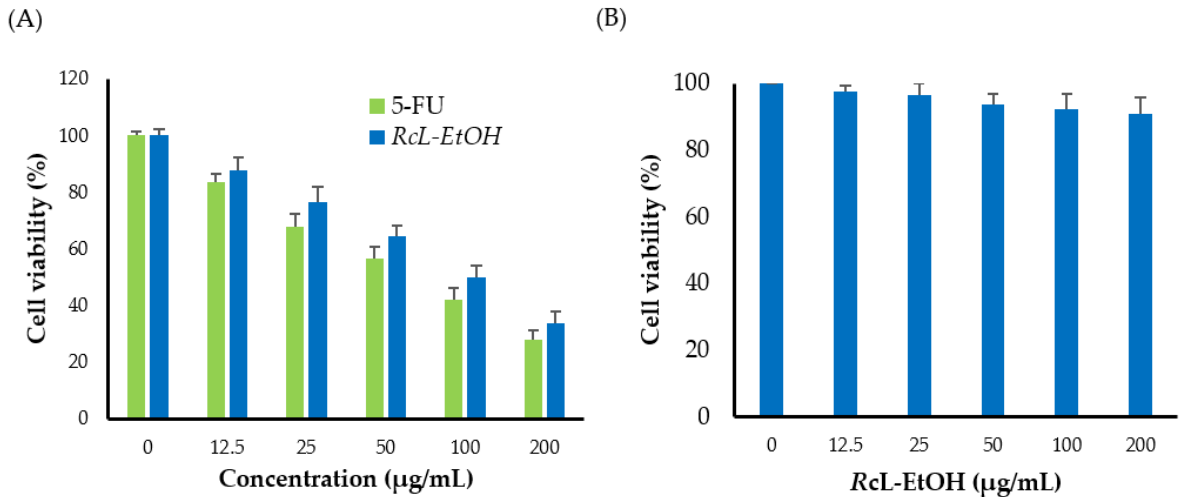
Figure 1. R cL-EtOH-mediated cytotoxicity in A549 cells. ( A ) Cell viability percentage of A549 cells post-treatment with either 5-fluorouracil (5-FU), and R cL-EtOH (0–200 µ g/mL) for 48 h. ( B ) Cell viability percentage of J774A.1 cells post-treatment with R cL-EtOH. Data represents mean ± SD (n = 3).